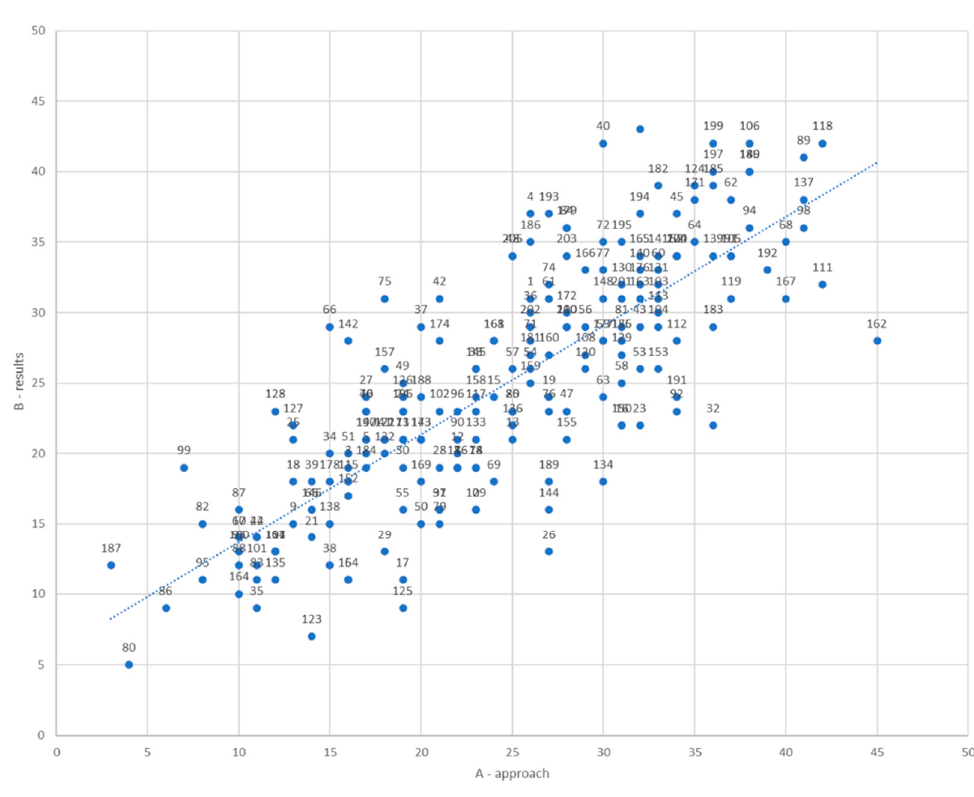
Table 4. Correlation between approach (the A questions) and results (the B questions). A B Spearman’s rho A Correlation coefficient 1.000 0.808 ** Spearman’s rho A Sig. (two-tailed) B Correlation coefficient 0.808 ** N 205